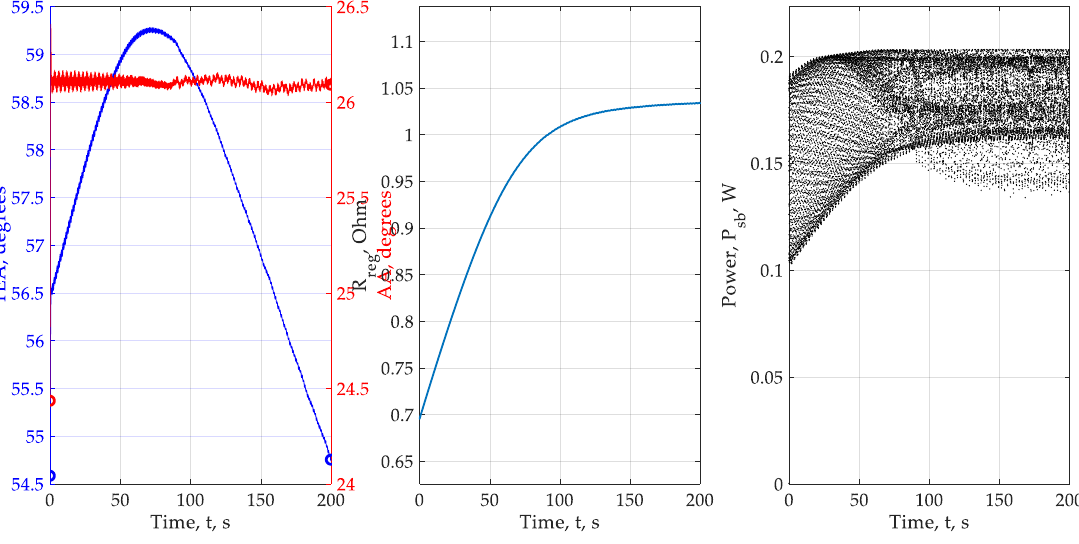
Figure 12. Experiment No.3 — Charles (2), 1981.